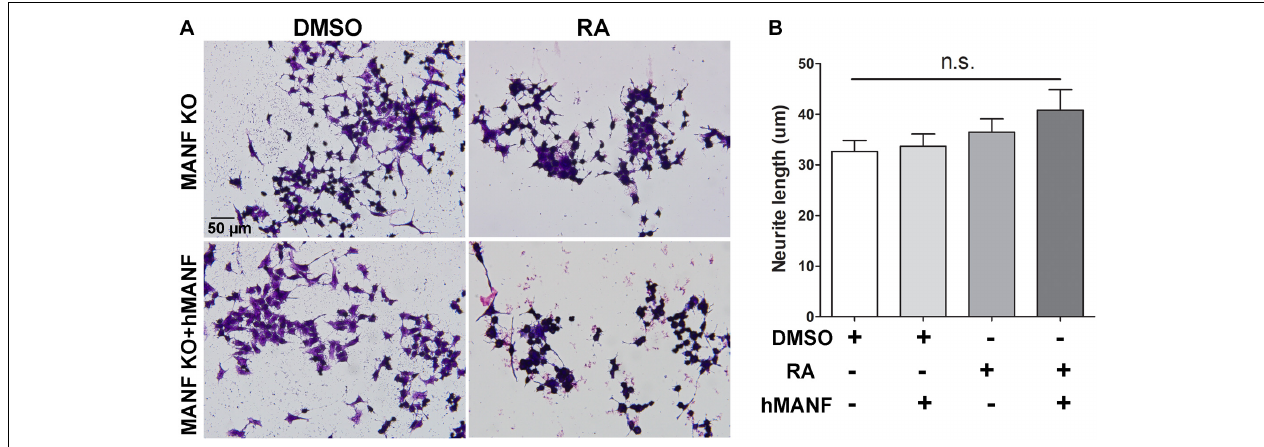
FIGURE 5 | Addition of extracellular hMANF fails to rescue the neurite outgrowth defects in MANF KO cells. (A) Representative images of MANF KO N2a cells treated with DMSO or RA for 3 days with or without addition of recombinant hMANF (100 ng/ml). Cells were fixed and stained with crystal violet for visualization. (B) Average neurite length was measured, and analyzed by One-way ANOVA followed with the Tukey’s post hoc test, n.s. not statistically significant. The data were expressed as the mean ± SEM of three independent